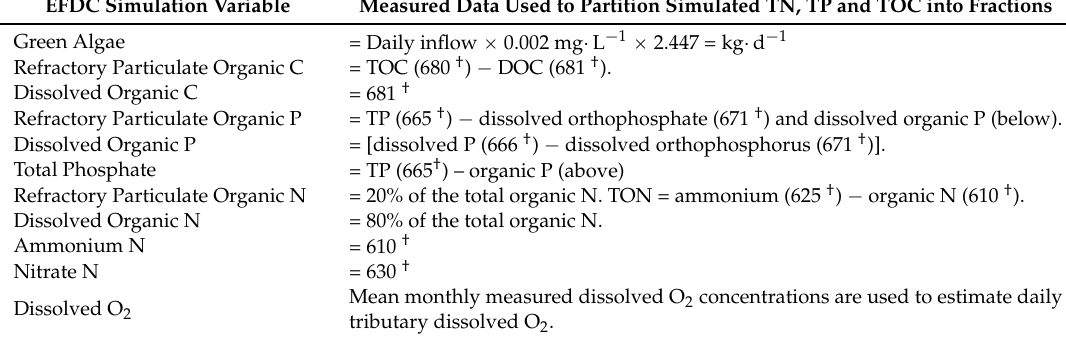
Table 2. Environmental Fluid Dynamics Code (EFDC) water quality simulation variables and measured data used to partition simulated total nitrogen (TN), total phosphorus (TP) and total organic carbon (TOC) into nutrient